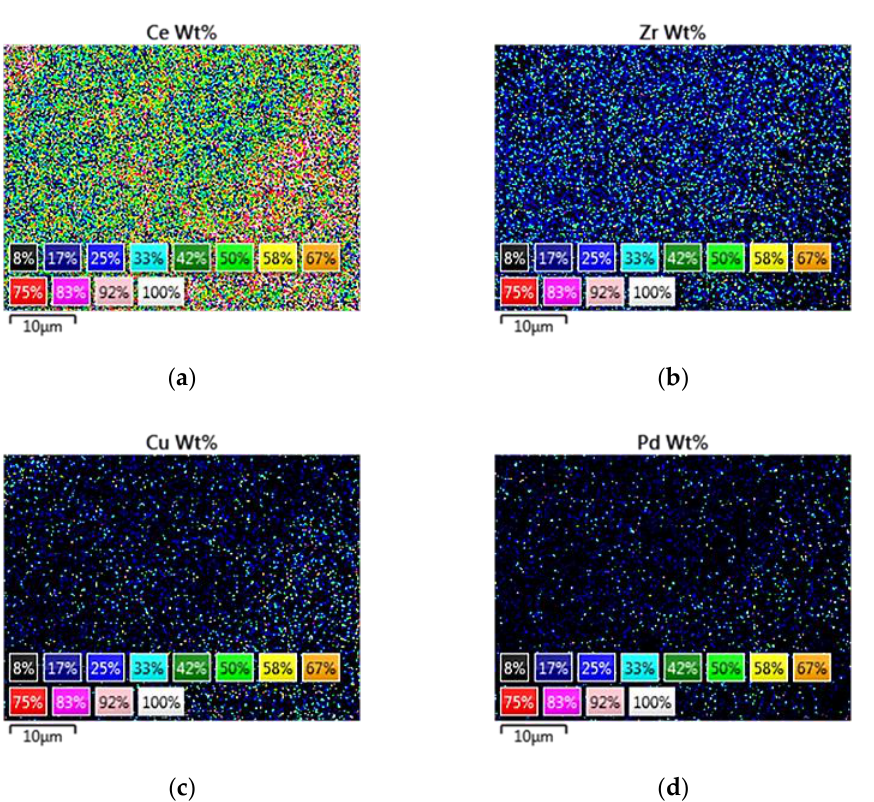
Figure 12. Distribution of: ( a ) Ce; (b) Zr; ( c ) Cu; ( d ) Pd for PROM5 catalyst. Table 3. Energy-dispersive X-ray spectroscopy (EDS) quantification analysis of PROM2 and PROM5.